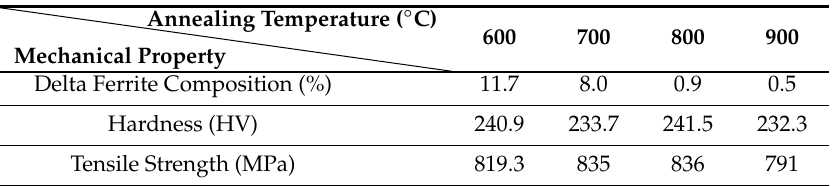
Table 5. Delta ferrite composition and mechanical properties of austenitic stainless steel at di ff erent annealing temperatures in the range of 600–900 ◦ C